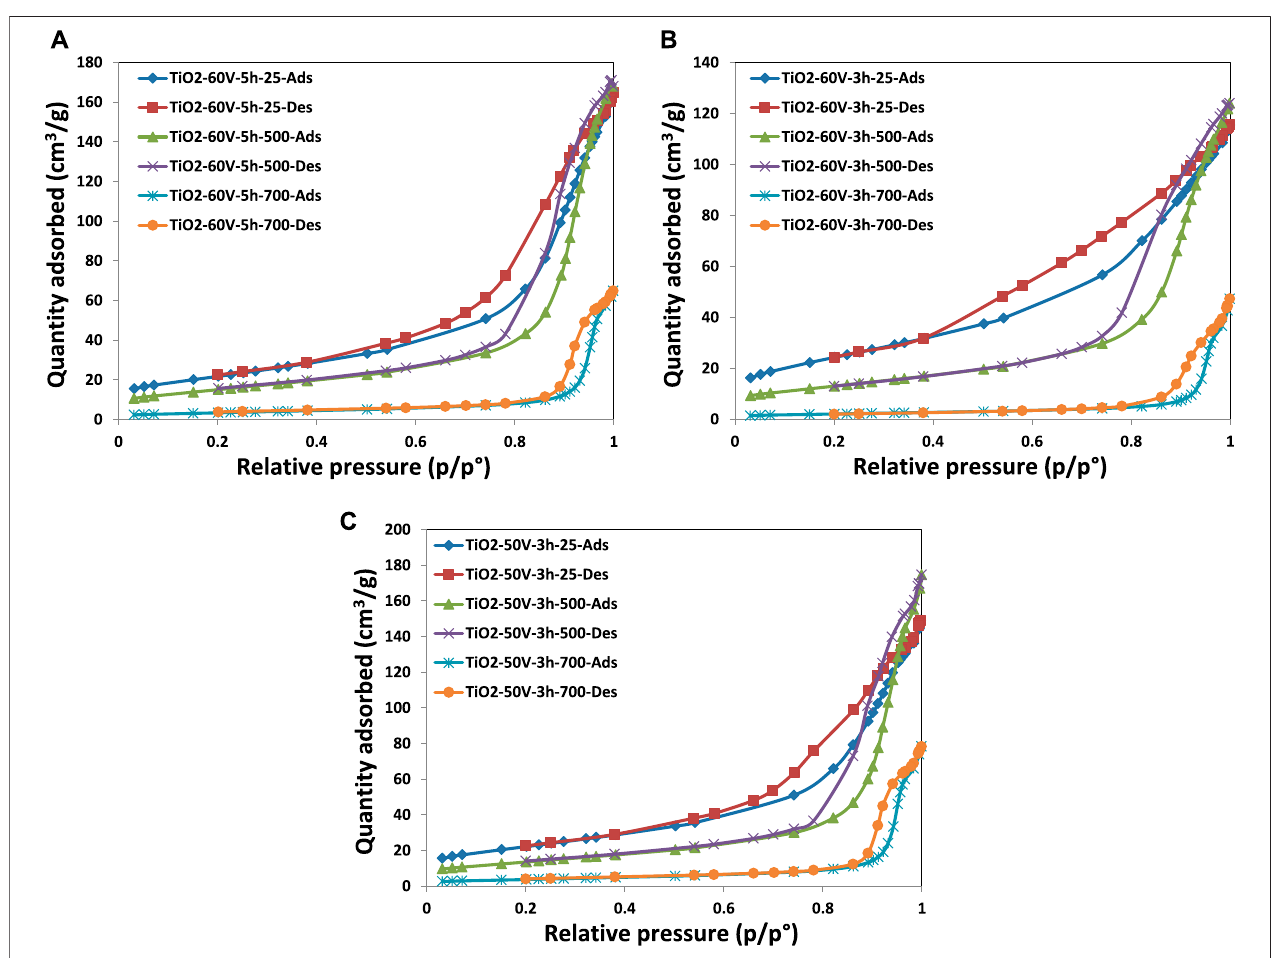
FIGURE 4 | BET isotherms of the TiO 2 samples: (A) TiO 2 -60V-5h, (B) TiO 2 -60V-3h, and (C) TiO 2 -50V-3h.